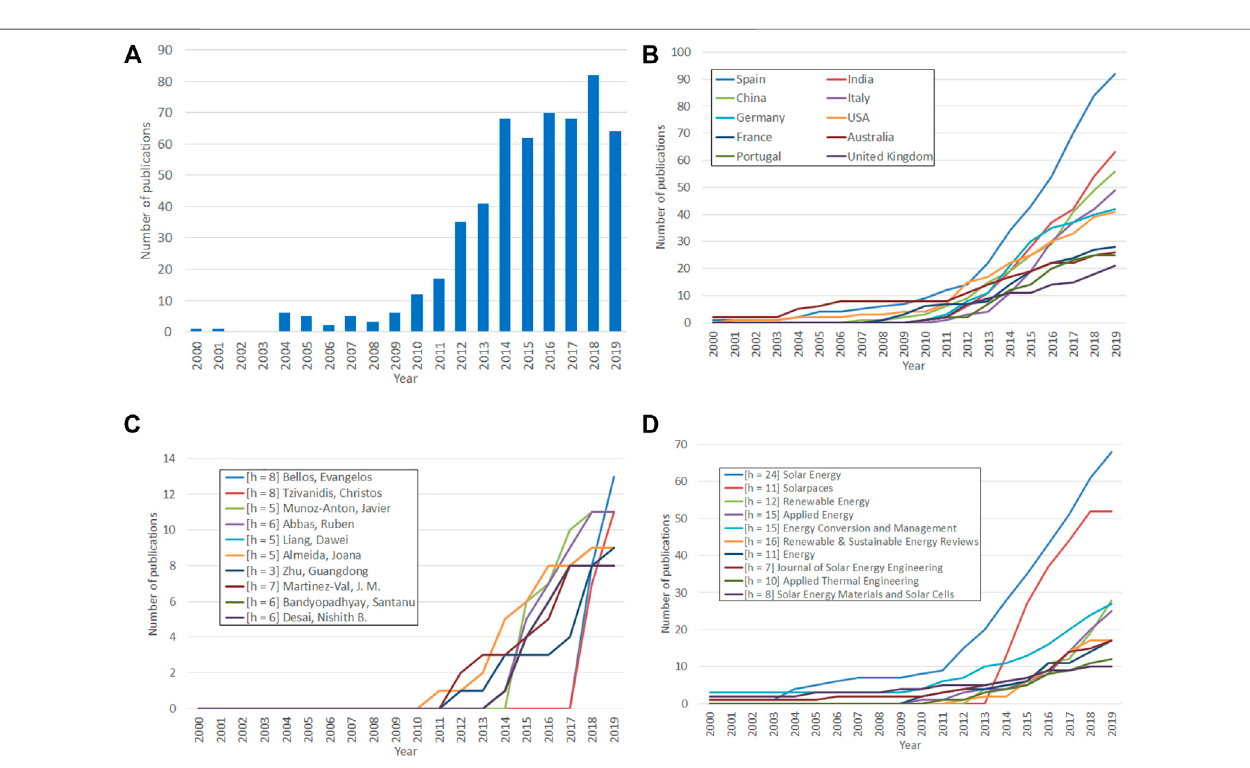
FIGURE 15 | (A) Total publication evolution in the Fresnel re fl ector fi eld per year; (B) Total publications in the Fresnel re fl ector fi eld per country; (C) Cumulative publication evolution per authors of the top ten authors in the Fresnel re fl ector fi eld; (D) Publication evolution per year of journals publishing in the Fresnel re fl ector fi eld.